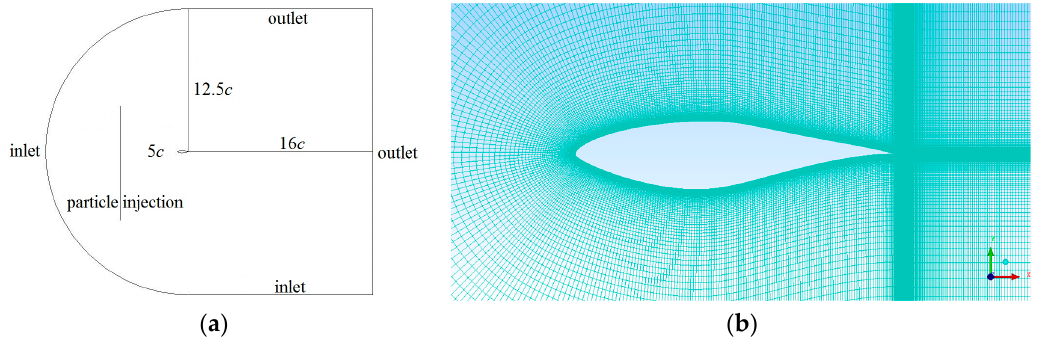
Figure 1. Computational domain and structured grid of S809 airfoil: ( a ) Computational model; ( b ) structured C-grid.